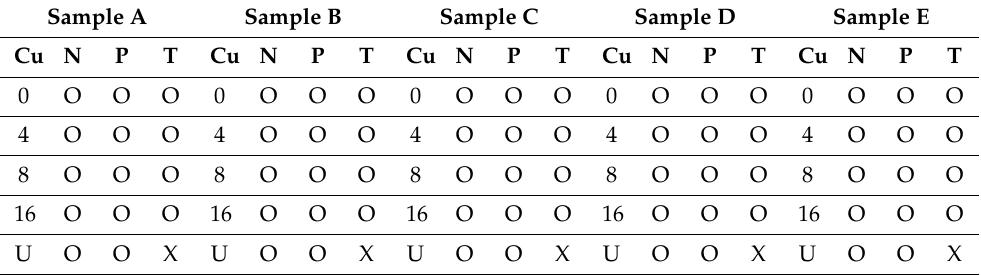
Table 1. Plate design. Cu is copper levels (0, 4, 8 and 16 µ M). N is non-stimulated. P is PPD-A stimulus. T is TLR2 ligand stimulus, Pam 3 CSK 4 . U is unstained sample for FACS calibration. Wells denoted X contain no cells or